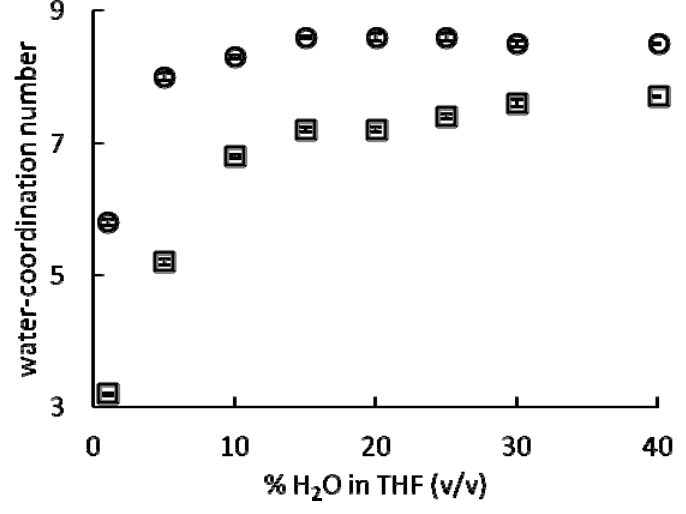
and (b) Eu(NO ) in 3 3 3